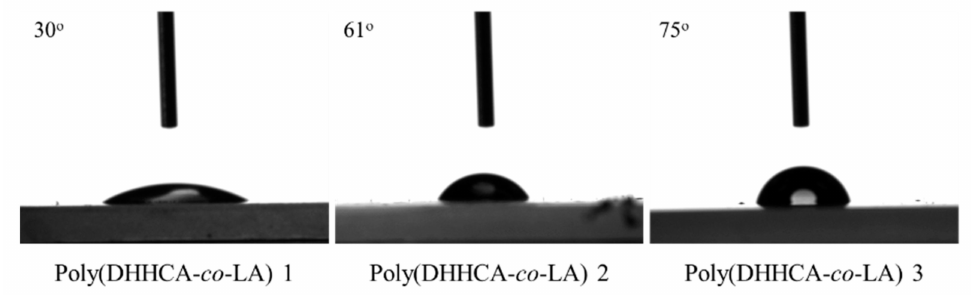
Figure 5. Water contact angle on poly(DHHCA- co -LA)1, poly(DHHCA- co -LA)2 and poly(DHHCA- co